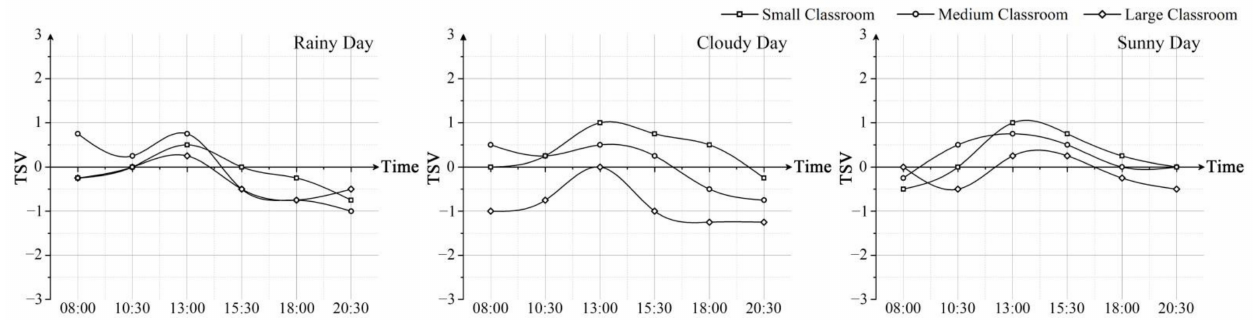
Figure 10. The TSV of the tested students in the three classroom-types under different weather conditions throughout the day.